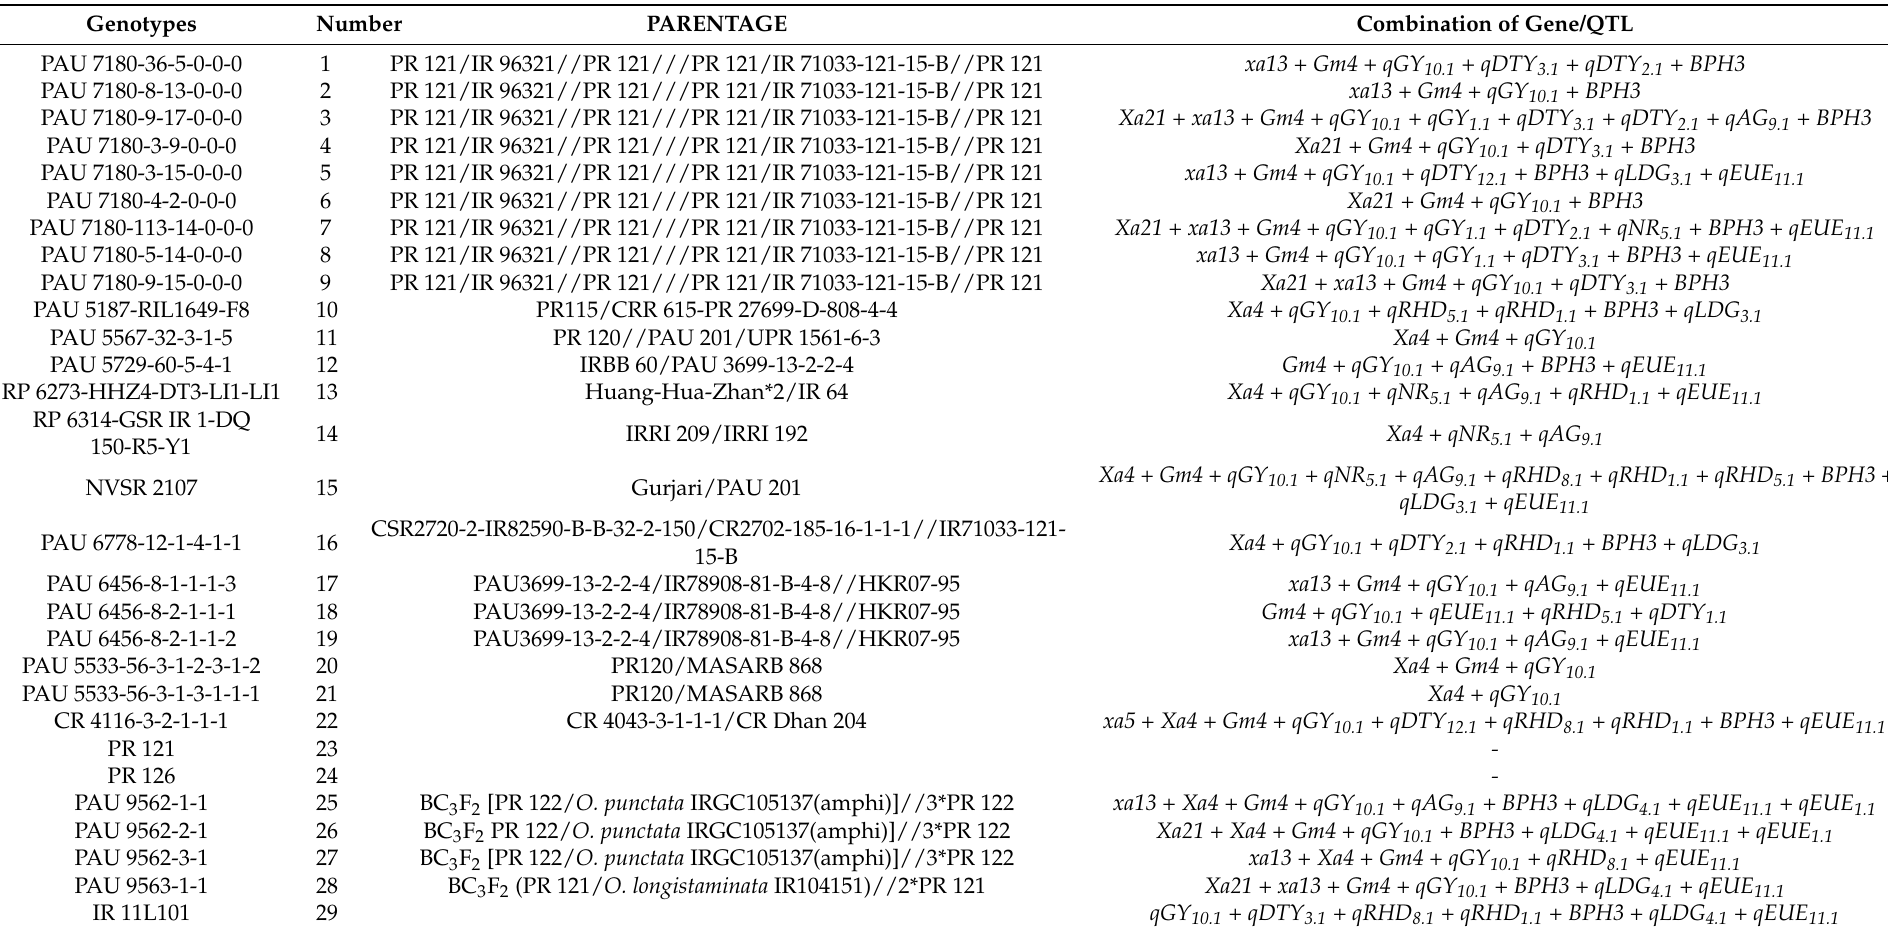
Table 1. The detailed information on the parentage and the QTL/genes identified in the breeding